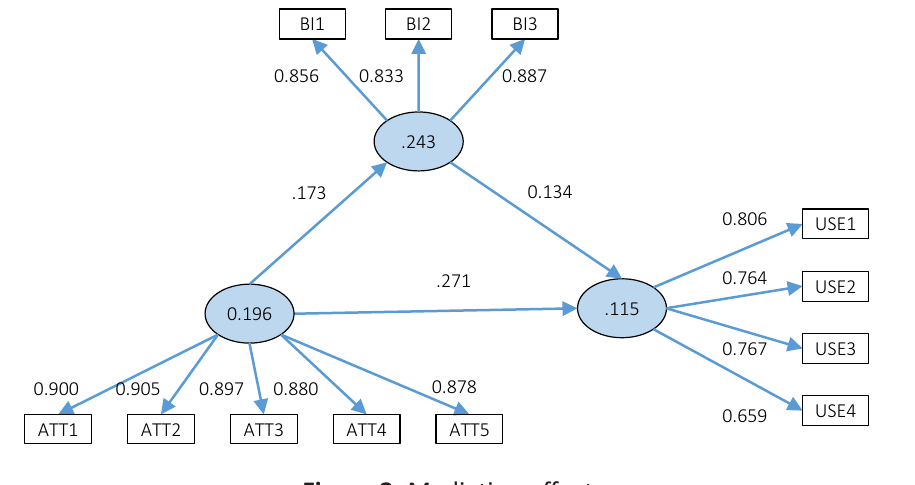
Figure 2. Mediation